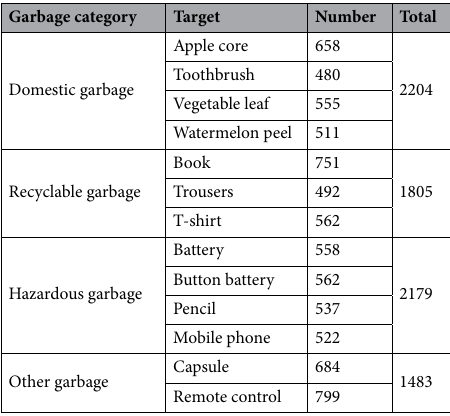
Table 4. Summary of the